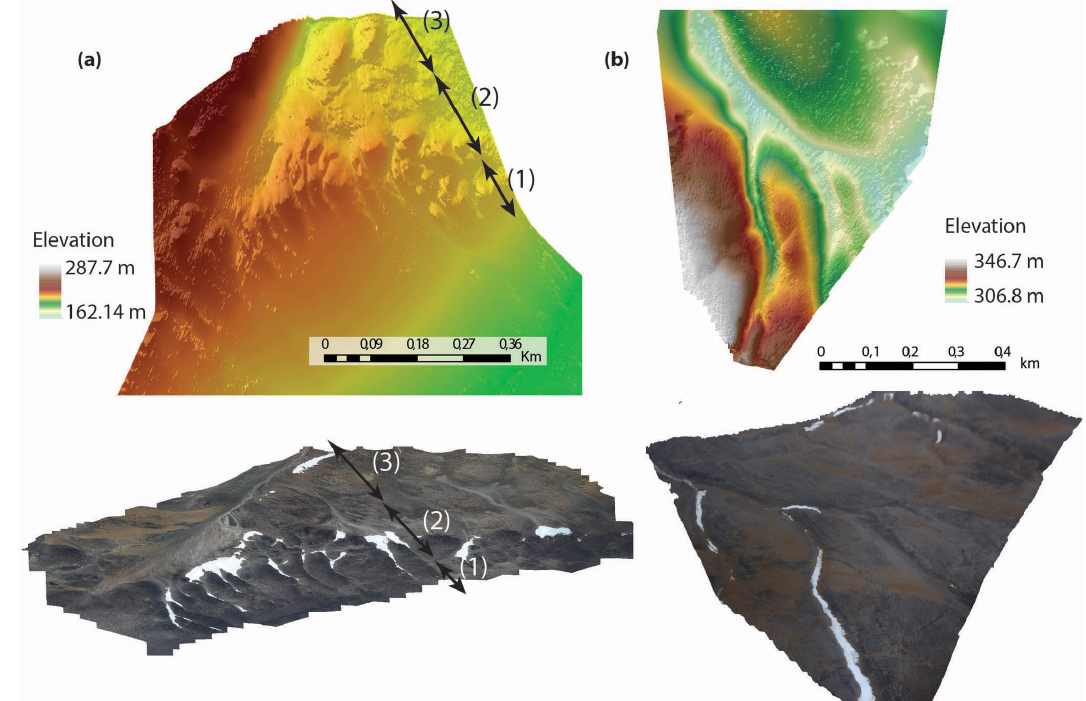
Figure 5. Stereo-photogrammetry derived from airborne photography. The top panels (a) and (b) show the DEM at a resolution of 0.48 and 0.56mpixel − 1 , respectively, with the color bar indicating the elevation of the model surfaces. The images underlying the panels correspond to the textured orthophotos in both